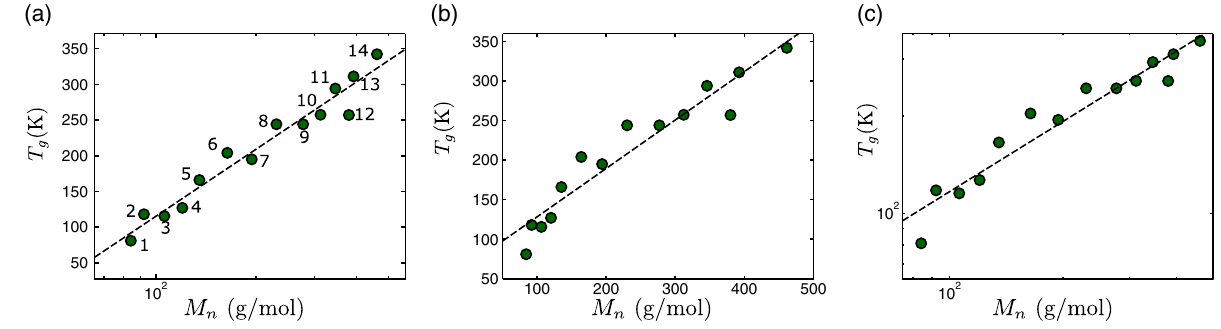
FIG. 15. T as a function of molecular weight M for rigid molecules from Table VI, as shown in semilogarithmic (a), linear (b), and g double-logarithmic (c) representations. The dashed lines are linear fits to the data in each representation, and they provide a guide to the eye for the evaluation of the degree of linearization provided in each